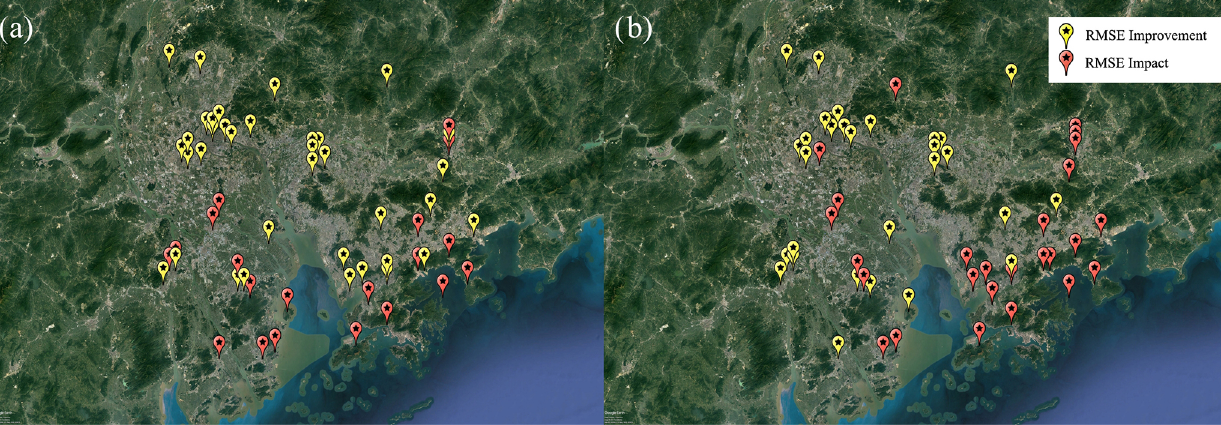
Figure 8. Spatial comparison of RMSE performance between the base case and blue-roof case: (a) January and (b) August. Stations with yellow colour indicates “RMSE improvement” where the RMSE of the blue-roof case is lower than the RMSE of the base case (RMSE blue-roof case − RMSE base case < 0). Stations with red colour refer to “RMSE impact” (RMSE blue-roof case − RMSE base case ≥ 0), meaning that the situation gets worse after using the blue-roof algorithm (© Google Earth).